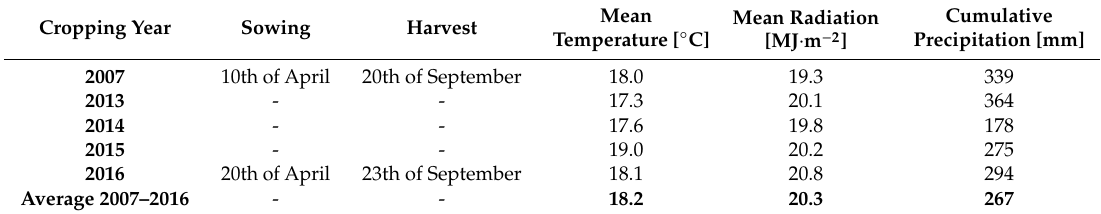
Figure 1. Top left: Fr ‐ Aur field and the location of the measurement station; Top ‐ right: Location of the study area in France; Bottom: Location of the fields in which biomass and yield data were collected in 2013, 2014, and 2015, as well as the selected area for the model’s upscaling (see Section 4.3). Table 1. Sowing and harvest dates of sunflower cultivated at FR-Aur and climatic variables averaged from the 15th of April to the 15th of September for all crop years. Bold values are averages over the 2007–2016